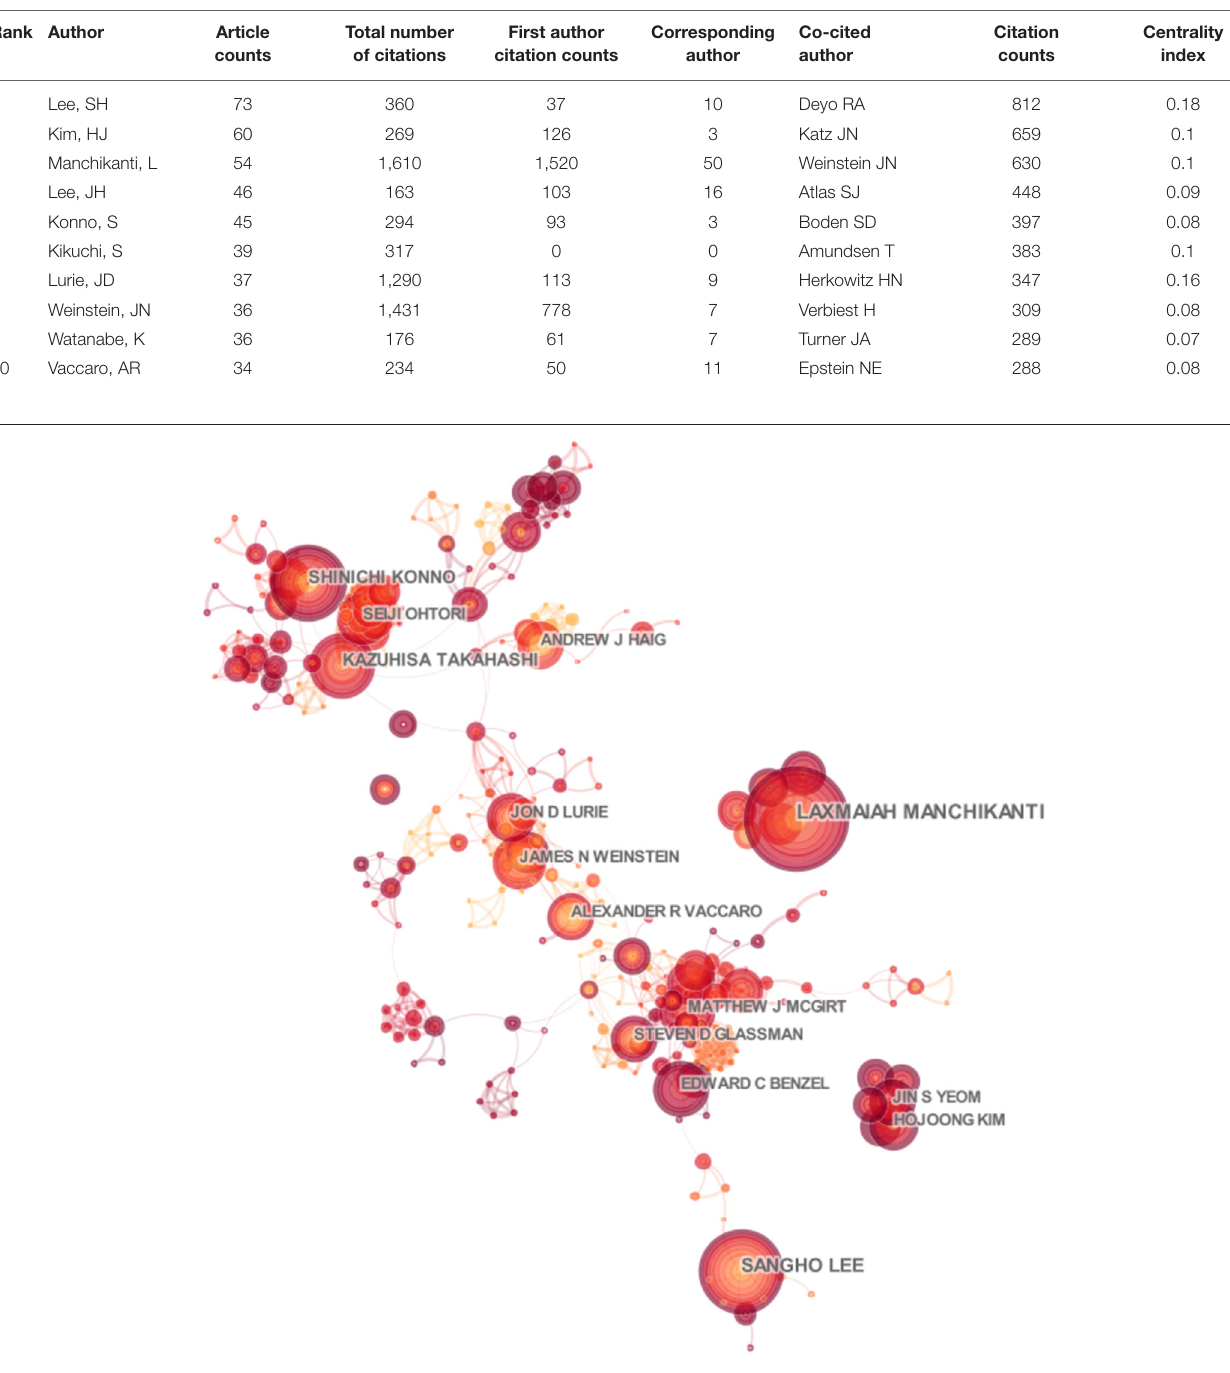
FIGURE 6 | Distribution characteristics of authors. The associated network of productive